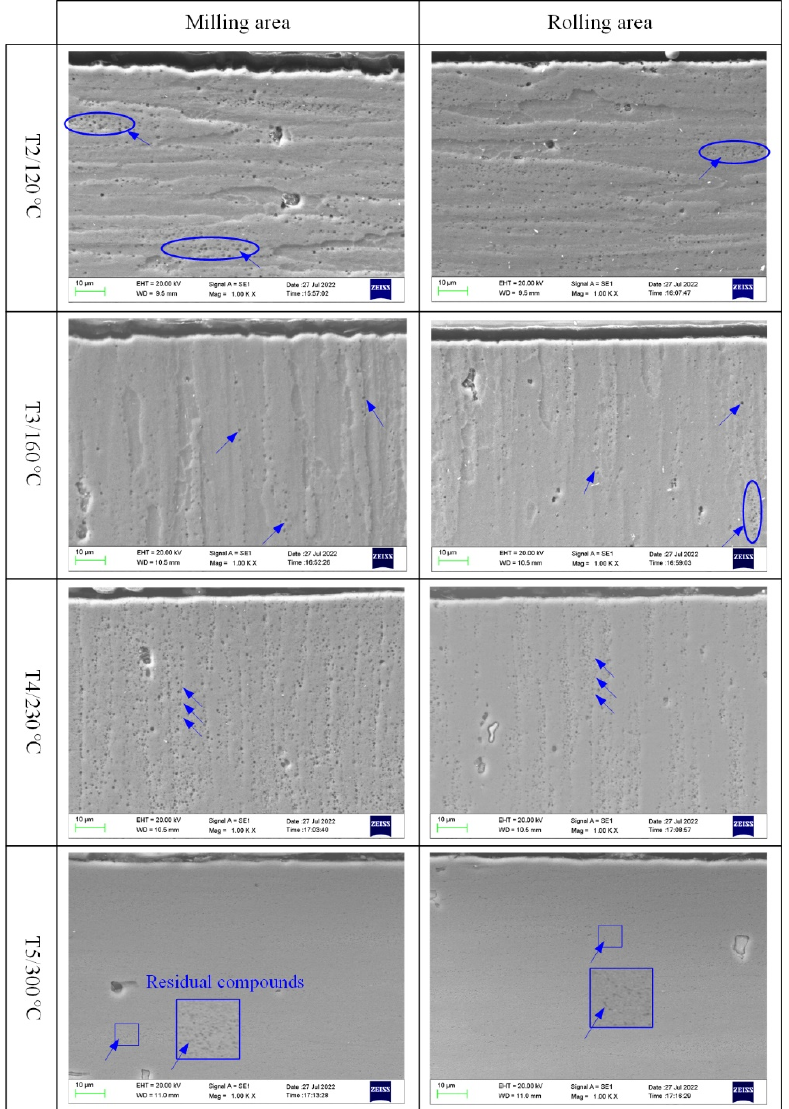
Figure 11. SEM morphology of the milling area and rolling area after different thermal load treat- ments.